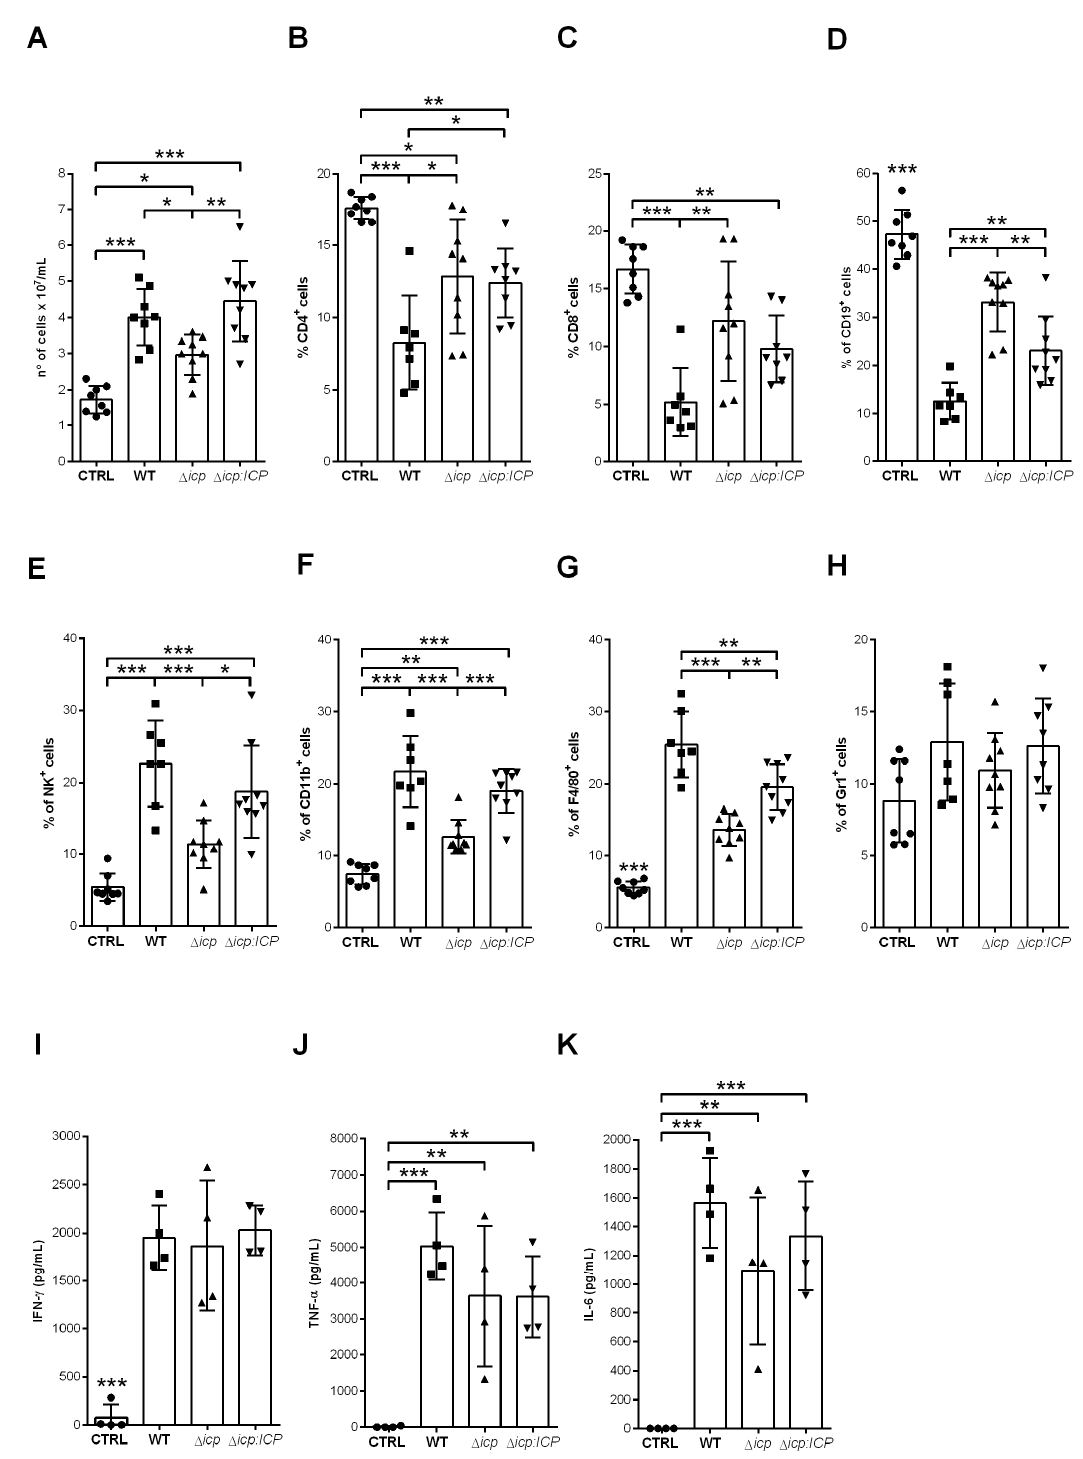
Figure 10. C57BL/6 infected with T. b. rhodesiense lacking ICP dampen the immune response in the spleen by day 14. C57BL/6 mice were infected with BSF parasites of T. b. rhodesiense WT, ∆ icp , and ∆ icp : ICP (1 × 10 5 parasites per animal). After 14 days, mice were euthanized and the spleens were collected, then macerated in order for ( A ) the cellularity to be determined. The splenocytes were submitted to flow cytometry ( B – H ) or were cultured for 24 h, after which the supernatant was collected. The splenocytes were submitted to flow cytometry to assess expression of ( B ) CD4, ( C ) CD8, ( D ) CD19, ( E ) NK1.1, ( F ) CD11b, ( G ) F4/80, and ( H ) Gr1 within the total cell population. Graphs show individual points representing each mouse sample and the mean ± SD of two independent